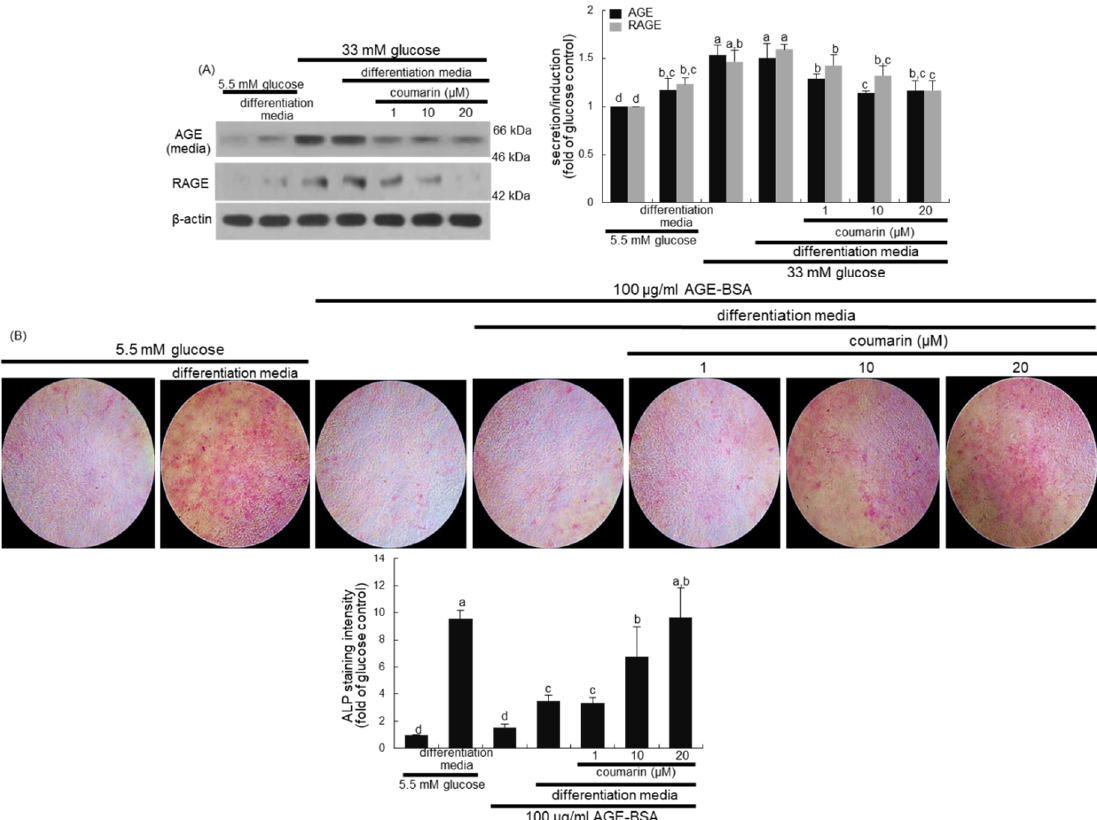
Figure 7. Inhibition of advanced glycation end-product (AGE) secretion and receptor for AGE (RAGE) induction ( A ) in osteoblastic MC3T3-E1 cells by coumarin. MC3T3-E1 cells were cultured for nine days in the presence of 1–20 µ M of coumarin. Cell media and lysates were subject to western blot analysis with a primary antibody against AGE and RAGE. Representative blot data were obtained from three independent experiments, and β -actin protein was used as an internal control. The bar graphs (mean ± SEM) in the bottom panel represent quantitative results obtained from a densitometer. MC3T3-E1 cells were cultured in di ff erentiation media containing 5.5 mM glucose or 100 µ g / mL AGE–bovine serum albumin (BSA) in the presence of 1–20 µ M coumarin on glass chamber plates for six days ( B ). Alkaline phosphatase (ALP) staining was proportional to the content of ALP enzyme activity from MC3T3-E1 cells. The intensity of ALP staining (mean ± SEM, n = 4) was measured using an optical Axiomager microscope system ( B ). The ALP staining was visualized under light microscopy. Magnification: 10-fold. Values not sharing a letter are di ff erent at p <